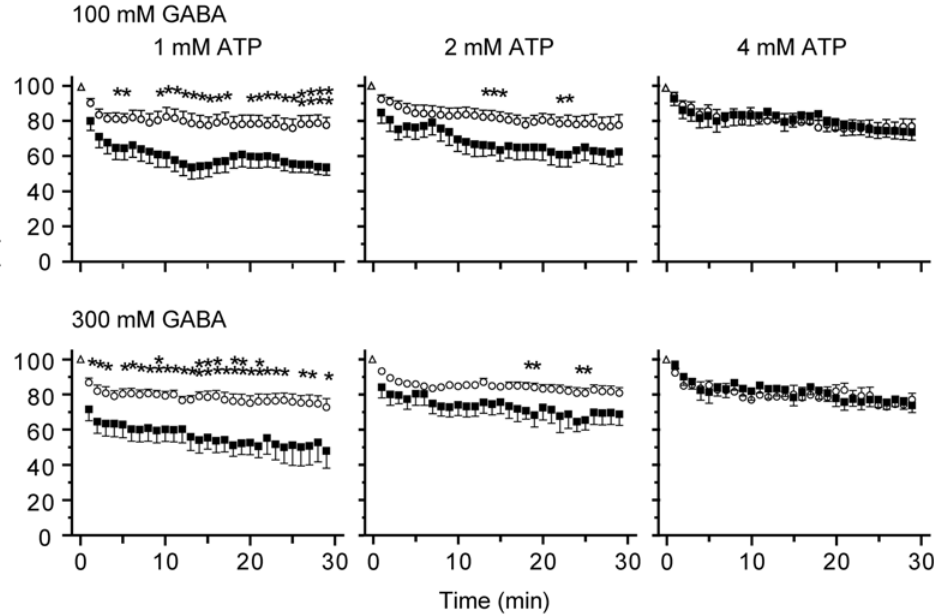
Figure 6. Variations of GABA-potentiated current rundowns with infused ATP. Currents were measured upon 30 successive additions of GABA at 1- minute intervals as described in Methods. Electrophysiological currents, expressed as a percentage of the peak current ( n ) measured upon initial response to stimulation by 100 m M (top row) or 300 m M (bottom row) GABA, were measured for a 1 b 2L c 2L ( & ) and a 1 b 2S c 2L ( # ) receptors with intracellular infusion of 1 mM, 2 mM or 4 mM ATP. Each data point represents average 6 standard error recorded from 7–10 cells from at least six independent transfections. Responses that were significantly different between the a 1 b 2L c 2L and a 1 b 2S c 2L receptors based on the two-tailed Student’s t -test are marked by asterisks (*, P , 0.05; **, P ,